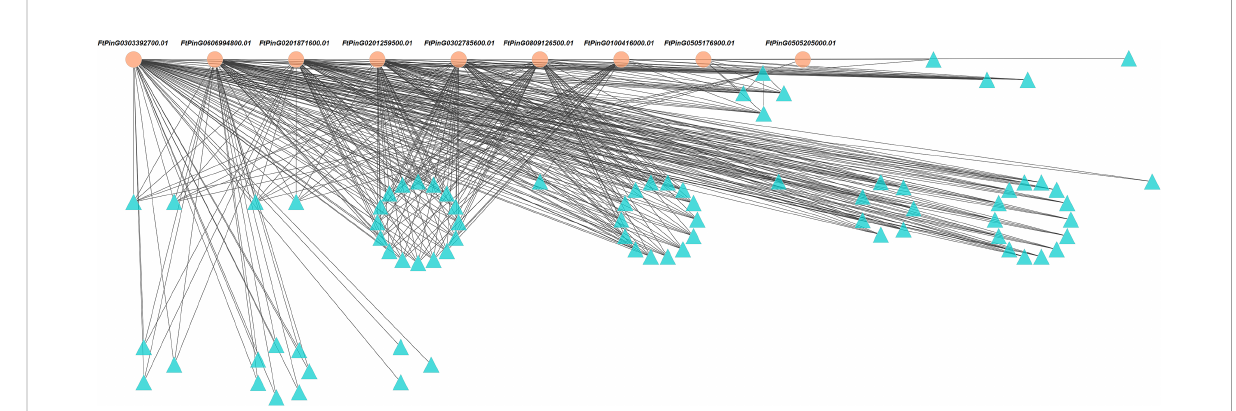
FIGURE 10 The interaction networks among 88 genes induced by Cd50 based on the gene expression pro fi le. The genes with orange background were 9 core genes expressed under Cd50. Cd50 indicates the Cd concentration of 50 mg/L.